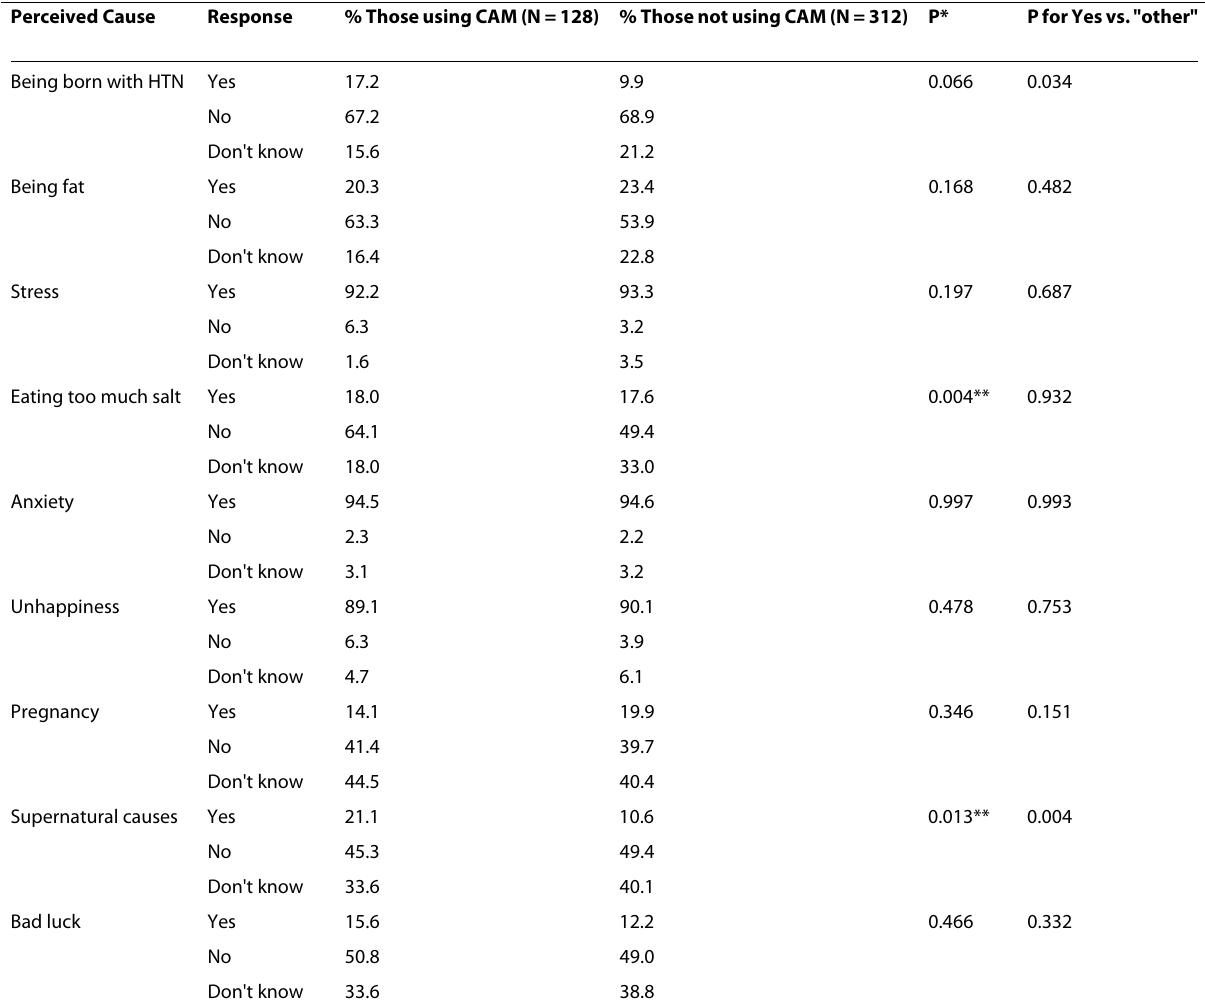
Table 3: Beliefs about cause of hypertension by use of CAM Perceived Cause Response % Those using CAM (N = 128) % Those not using CAM (N = 312) P* P for Yes vs. "other" Being born with HTN Yes